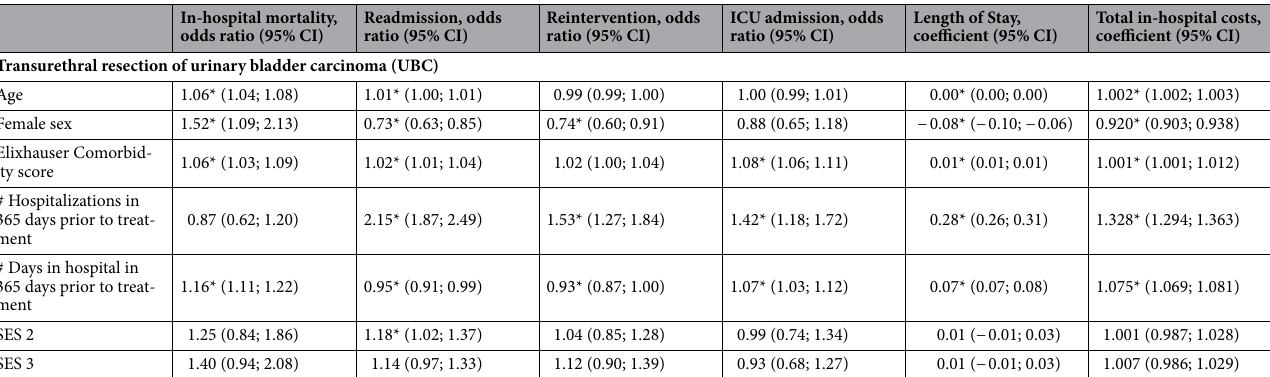
Table 4. Prognostic factors for outcomes and costs for urinary bladder carcinoma, where * p ≤ 0.05.